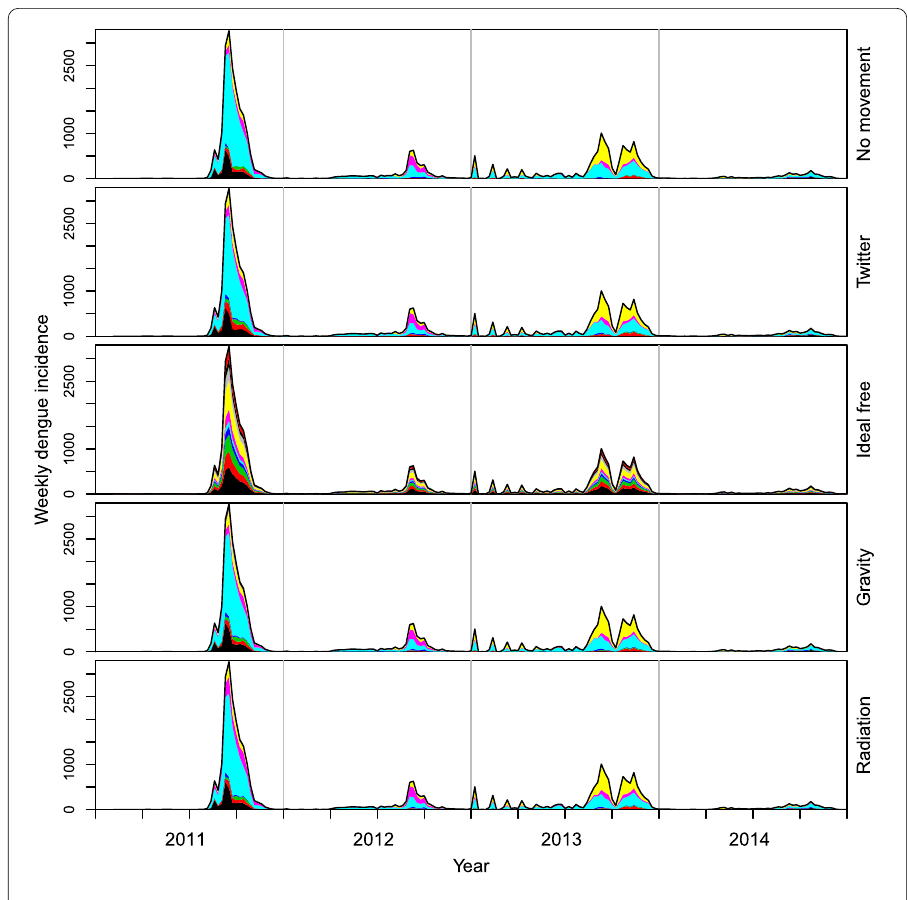
Figure 2 Time series stratified by towns in which cases were assumed to be acquired (colors) under five different assumptions about mobility among towns